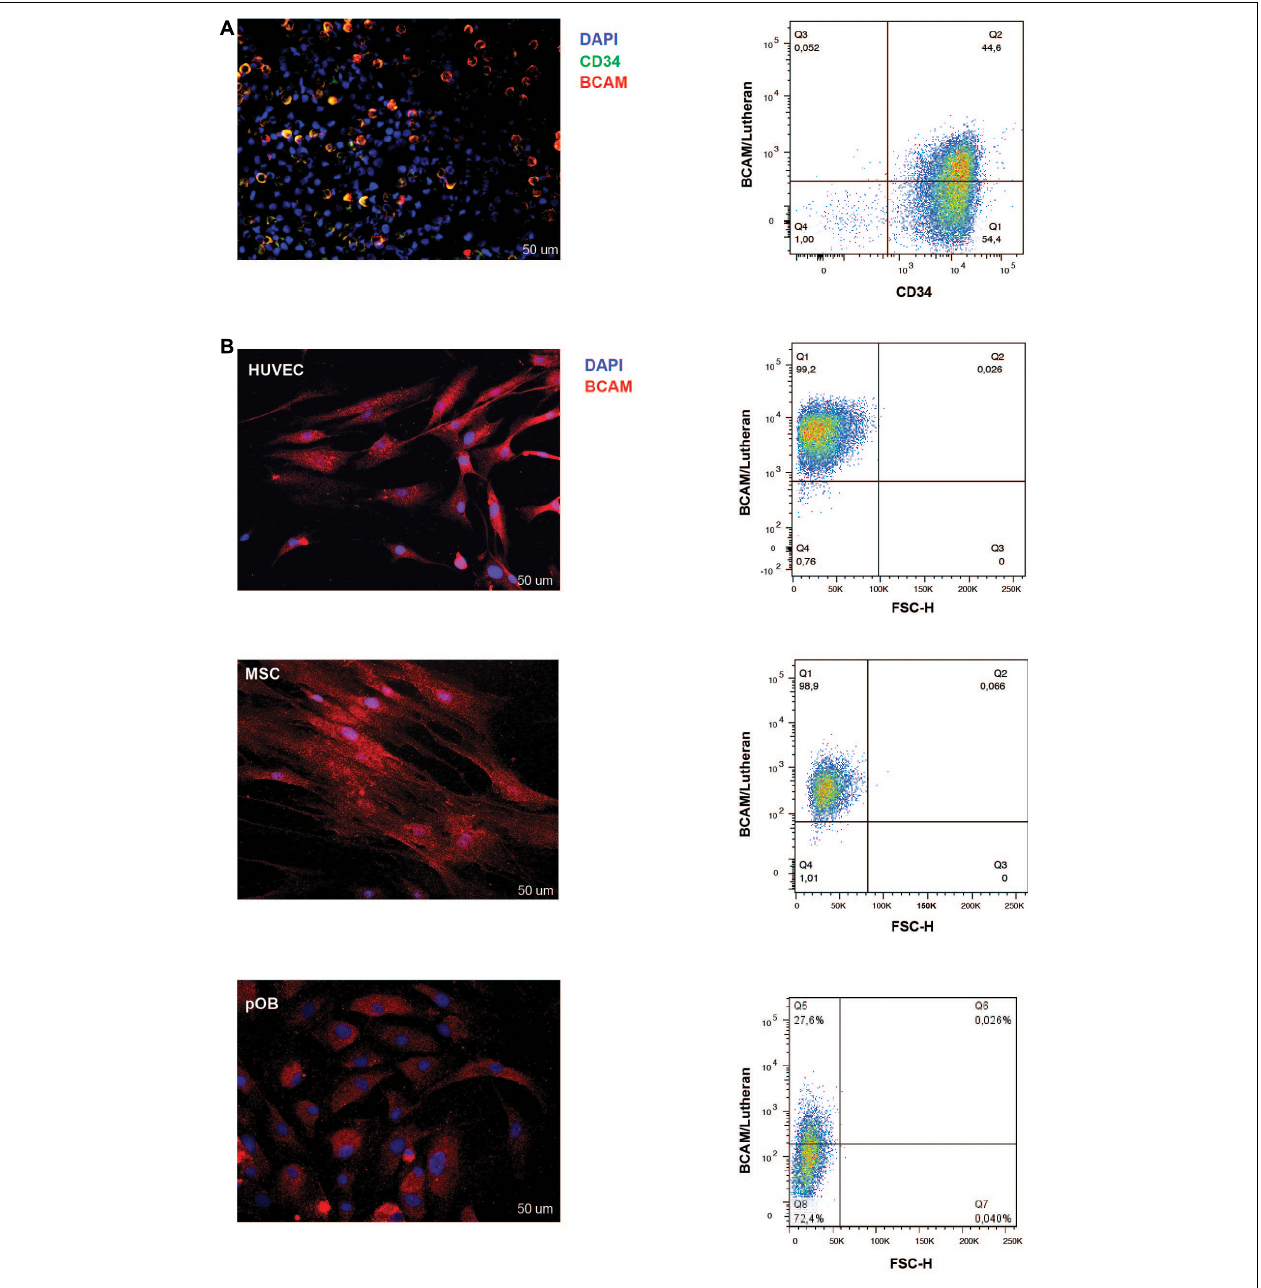
FIGURE 2 | BCAM/Lu expression on CD34+ cells, HUVEC, MSC, and pOB. (A) Left: Lineage-negative CBMNC were double-stained with mouse-anti-BCAM/Lu and rabbit-anti-CD34 antibodies followed by Cy3- and Alexa 488-conjugated secondary antibodies, respectively. Cell nuclei of all lineage- cells were counterstained with DAPI (blue signal). The majority of the CD34 + HSPC express BCAM/Lu as seen in the merged immunofluorescence micrograph. Scale bar: 50 µ m. Right: FACS blots representing the expression of BCAM/Lu on 50% of the CD34 + HSPCs. (B) Left panel: The adherent cells – endothelial, mesenchymal stromal or osteoblastic cells – were labeled with the BCAM/Lu antibody and Cy3-conjugated secondary antibody. Cell nuclei were counterstained with DAPI. Strong immunofluorescence signals were seen on HUVEC and MSC, weaker signals were found on pOB. Scale bar: 50 µ m. Right panel: FACS blots representing the expression of BCAM/Lu on HUVEC, MSC, and pOB (top to bottom). Representative plots of three independent experiments.